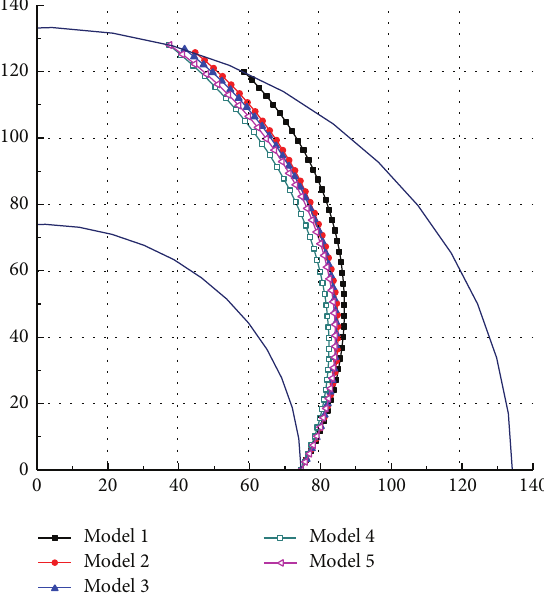
Figure 7: The camber line profiles of 5 impeller